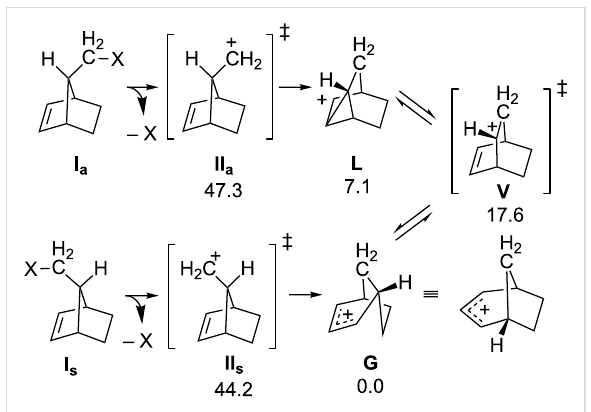
Figure 1: Corrected Figure 6 of the original article. The portion of the norborn-2-en-7-ylmethyl cation PES examined by Ghigo et al. [60]. Energies reported are electronic energies, including zero-point correc- tions (ZPE), at the B3LYP/6-31G(d) level of theory and are all relative to that of G [61-63] (for references see original